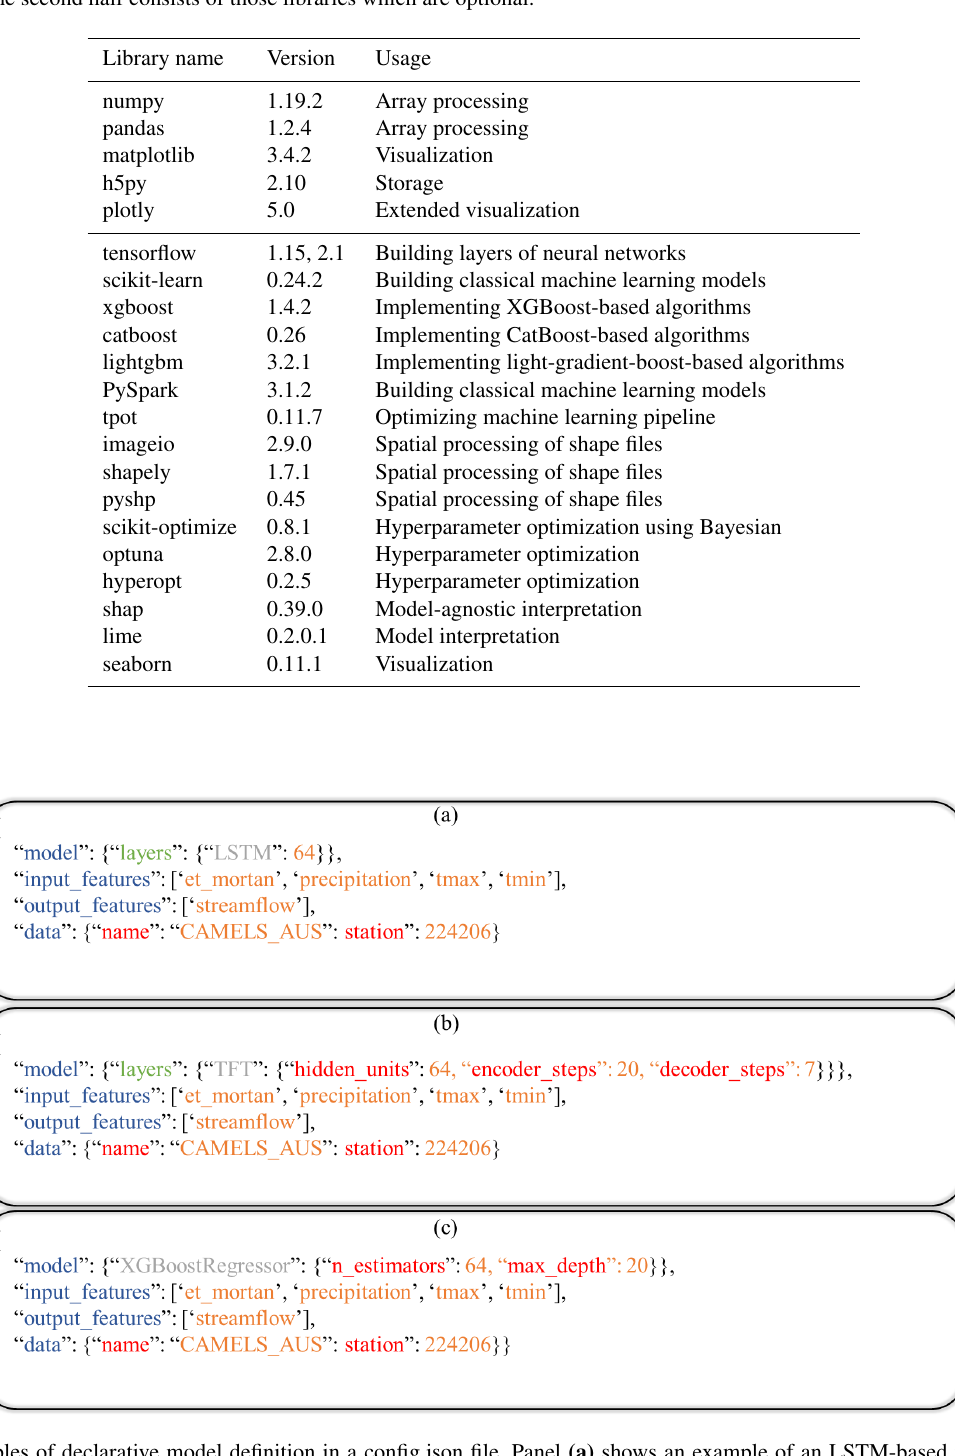
Table 1. Complete list of third-party Python libraries which are used by AI4Water. The first half the table enlists those libraries which are required, while the second half consists of those libraries which are optional.